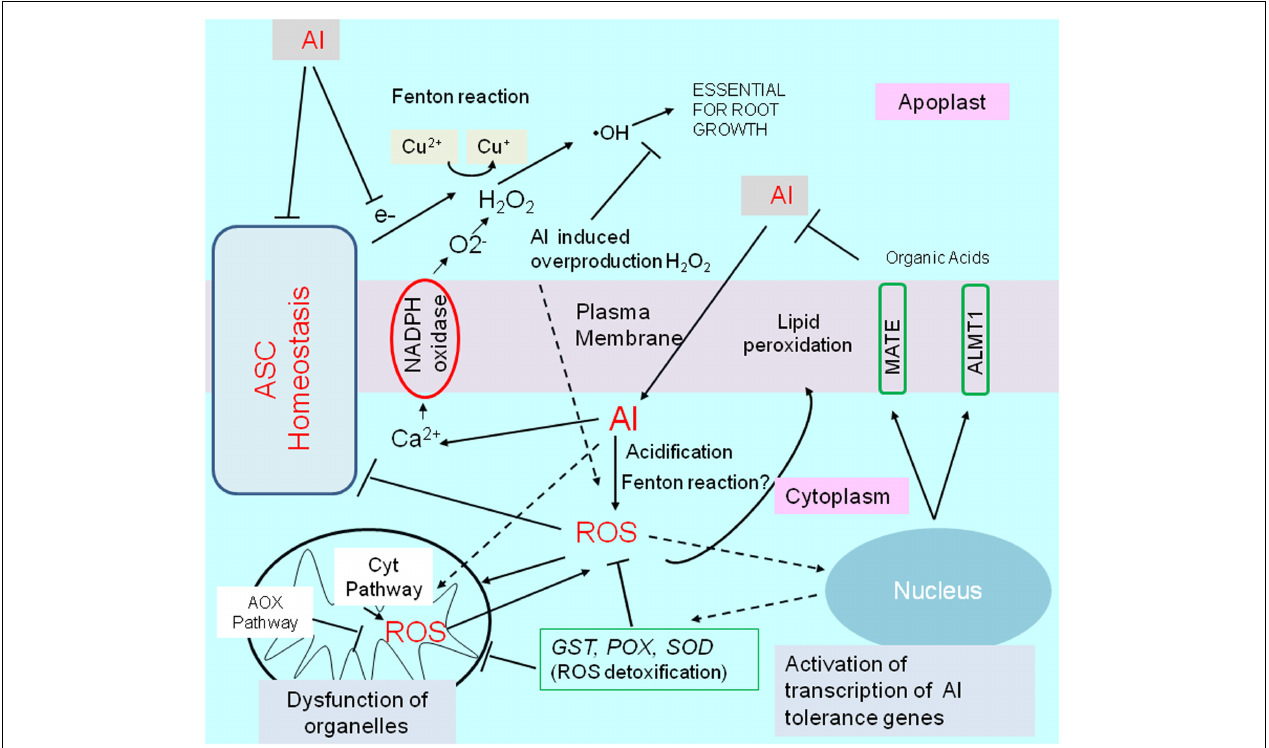
FIGURE 4 | Schematic representation of aluminum-induced reactive oxygen species (ROS) stress, and activation of tolerance mechanisms by ROS. Aluminum disturbs an essential fenton reaction in the cell wall for root growth, but is induced ROS production by (1) increases cytosolic Ca 2 + concentrations, which triggers activation of NADPH-oxidase, (2) inducing fenton reaction in cytosol, (3) cytosol acidification, and by other mechanisms. Disturbance of ascorbate (ASC) homeostasis enhance abnormal fenton reaction in apoplast, and ROS production in the cytoplasm. Aluminum (or by generated ROS) shifts mitochondrial respiration to an alternative pathway (AOX pathway) from Cyt pathway (cytochrome pathway), which is likely important to protect mitochondrial function. ROS activates transcription of several genes for ROS detoxifying enzymes such as GLUTATHIONE–S-TRANSFERASE (GST); PEROXIDASE ( POX ); SUPEROXIDE DISMUTASE ( SOD ), which can confer Al resistance in some plant species by overexpression. ROS, in particular, H 2 O 2 is known as a inducer of an Al tolerance genes such as ALUMINUM ACTIVATED MALATE TRANSPORTER1 ( ALMT1 ) and MULTIDRUG AND TOXIC COMPOUNDS EXTRUSION ( MATE ) in